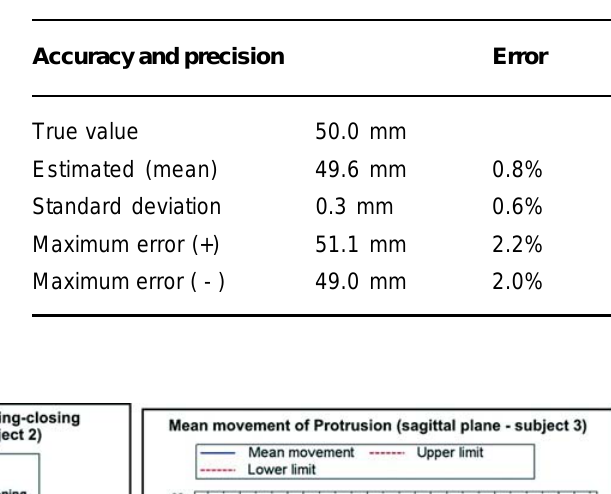
TABLE 1- Accuracy and precision of the experiments